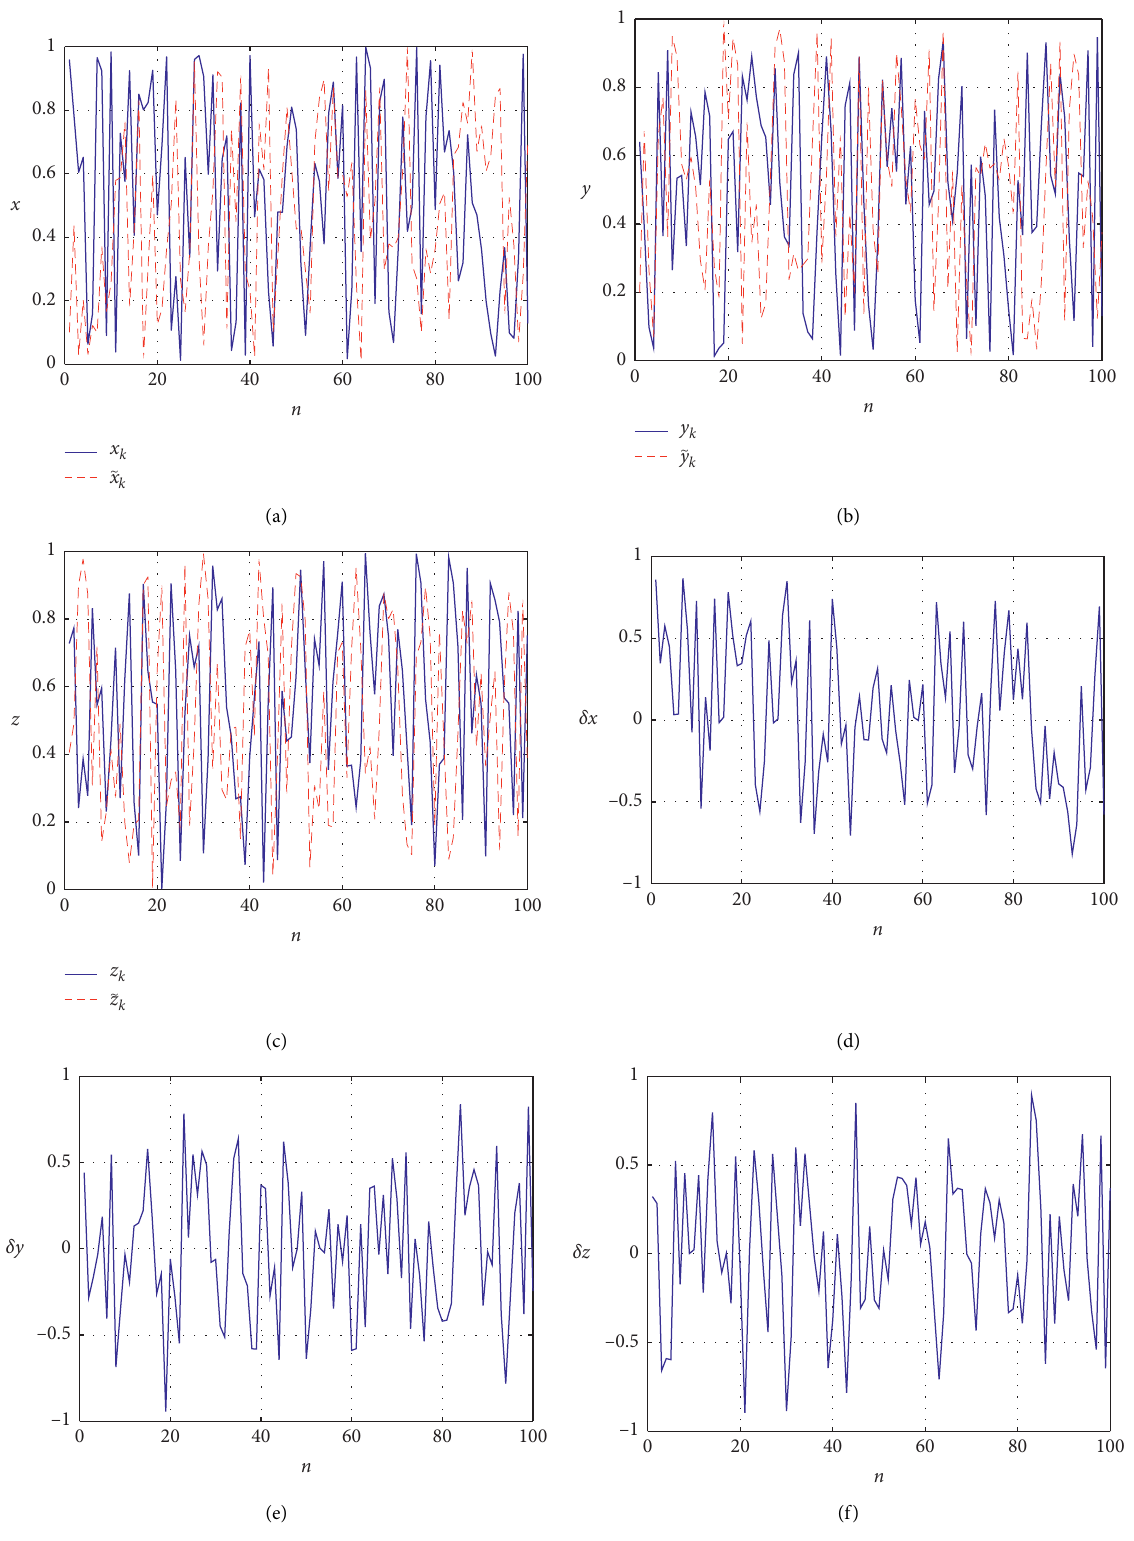
Figure 4: Initial value sensitivity for 100 iterations when c � 15, ( x and δ ≈ 10 − 16 . (a) Plot of x n 􏼈 􏼉 n � 100 n � n ; (d) plot of x